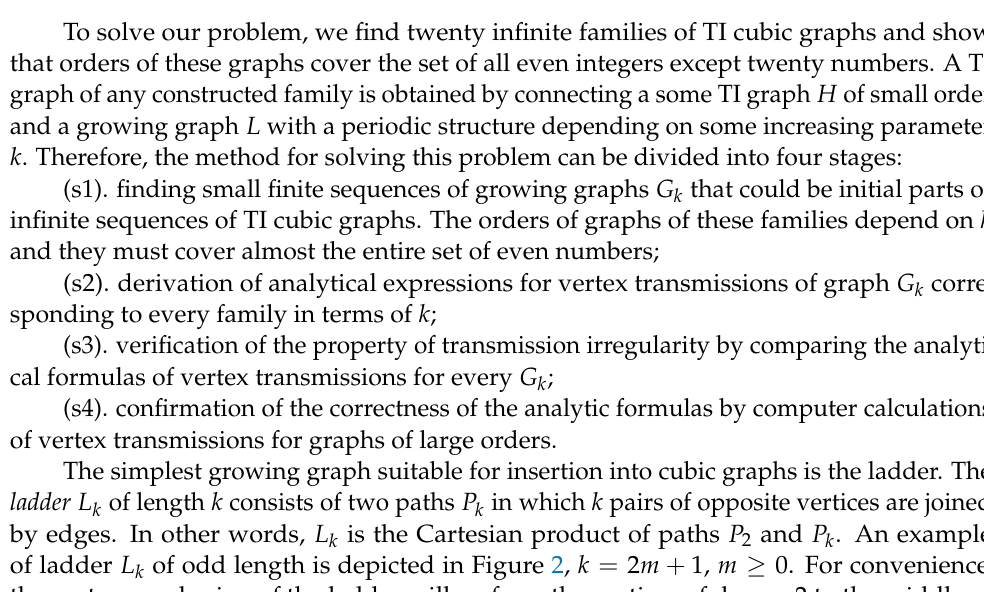
Figure 1. Transmission irregular cubic graphs with 22 and 24